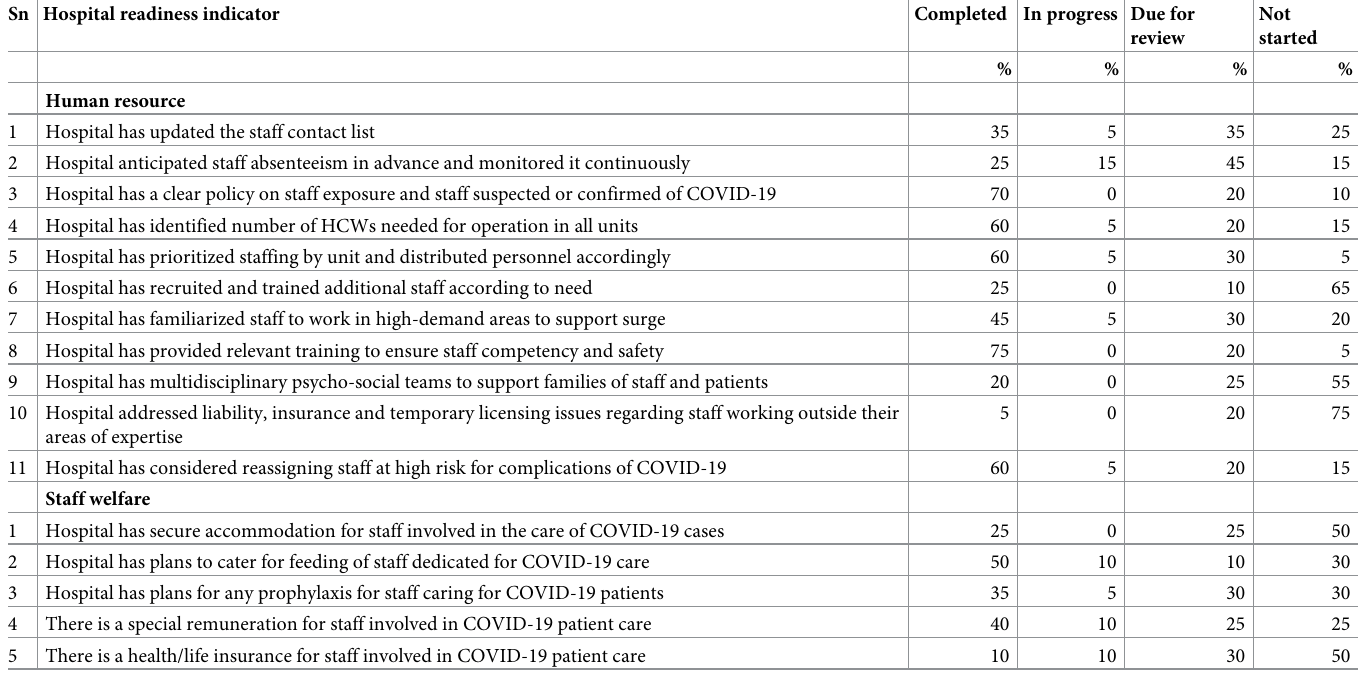
Table 6. Implementation of human resources and staff welfare readiness indicators among 20 hospitals in Nigeria. Sn Hospital readiness